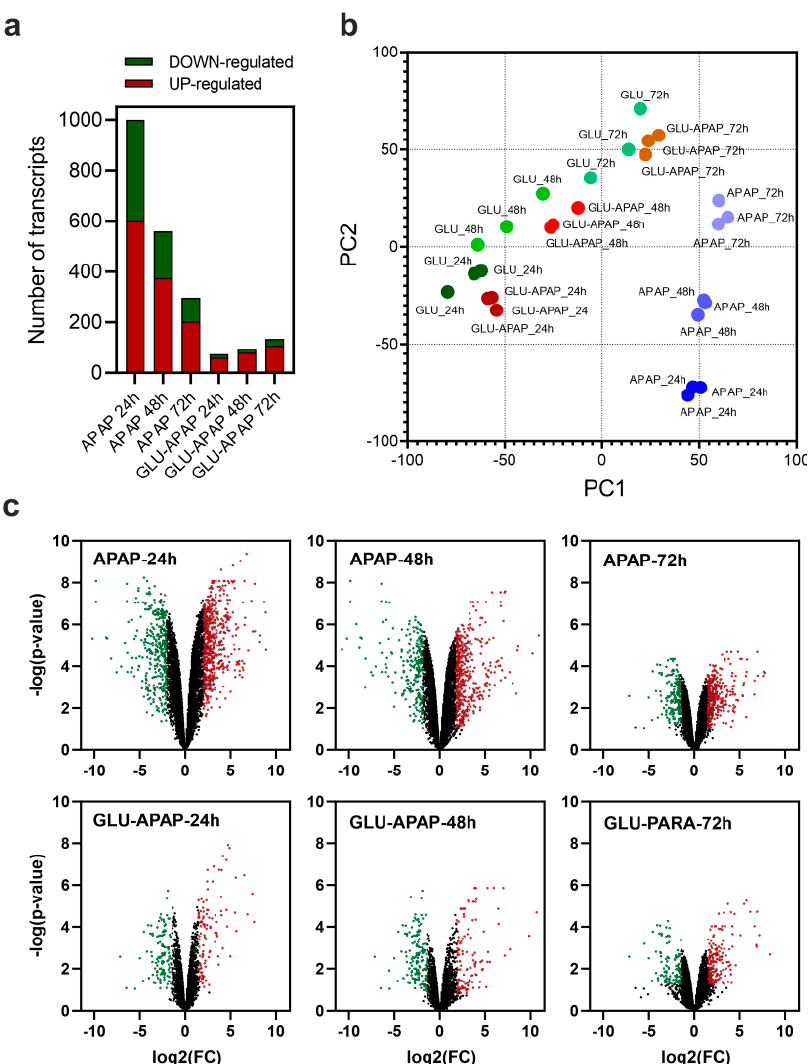
Figure 2. Transcriptomic analysis of P. chrysogenum var. halophenolicum during APAP degradation. ( a ) Number of differentially expressed mRNA transcripts at 24, 48, and 72 h of culture in media containing APAP or APAP and glucose as carbon sources refer to the cultures growth using only glucose. ( b ) Principal component analysis of gene expression in all the samples of the experiment using glucose (GLU), APAP (APAP), and glucose + APAP (GLU-APAP) as carbon sources. ( c ) Volcano plots of differentially expressed mRNA transcripts in presence of APAP or APAP and glucose, referred to the respective cultures growth in glucose as carbon source. Differentially expressed genes were considered when p -value < 0.05 and a − 2.0 > logFC > 2.0, calculated by the EdgeR algorithm. In the volcano plots, upregulated gene transcripts are represented as red dots and downregulated transcripts by green